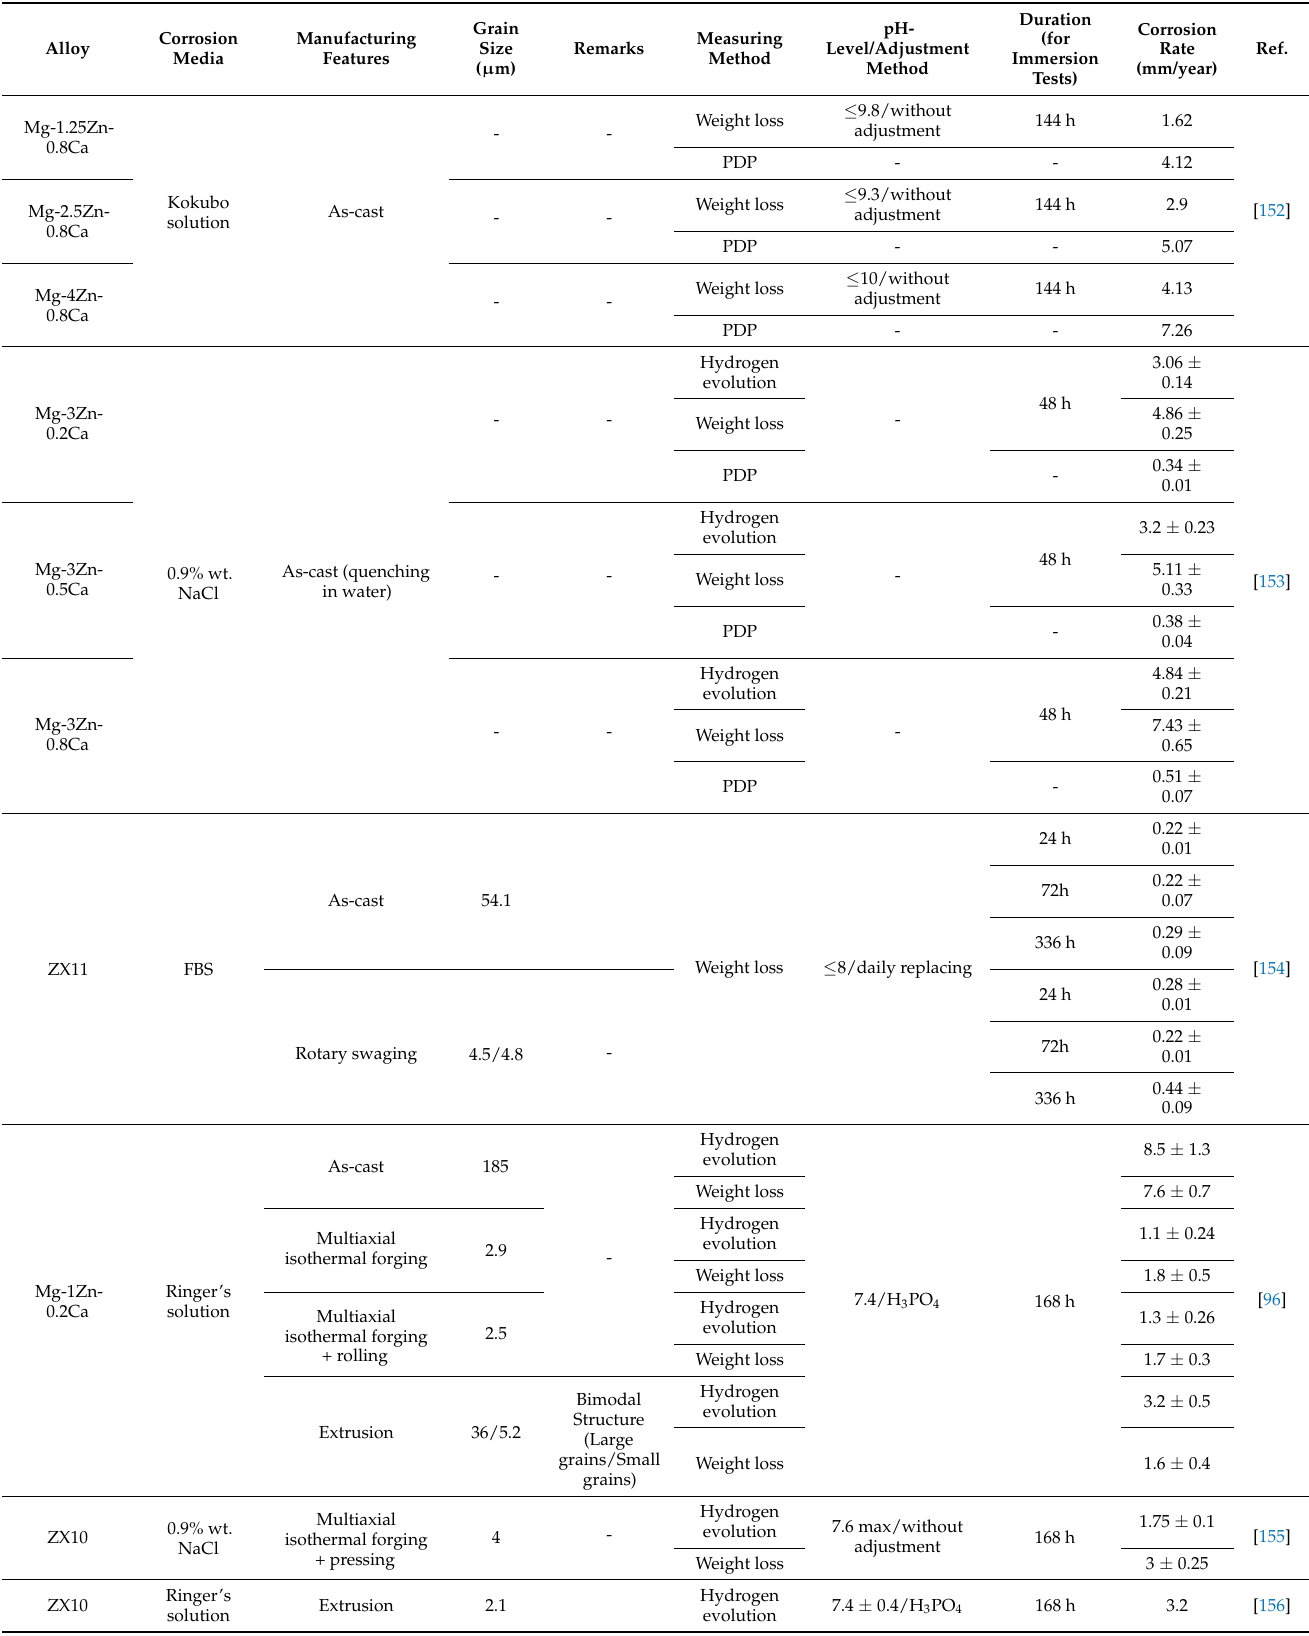
Table 4. Corrosion rate of biodegradable Mg-Zn-Ca alloys in other corrosion media with 37 ◦